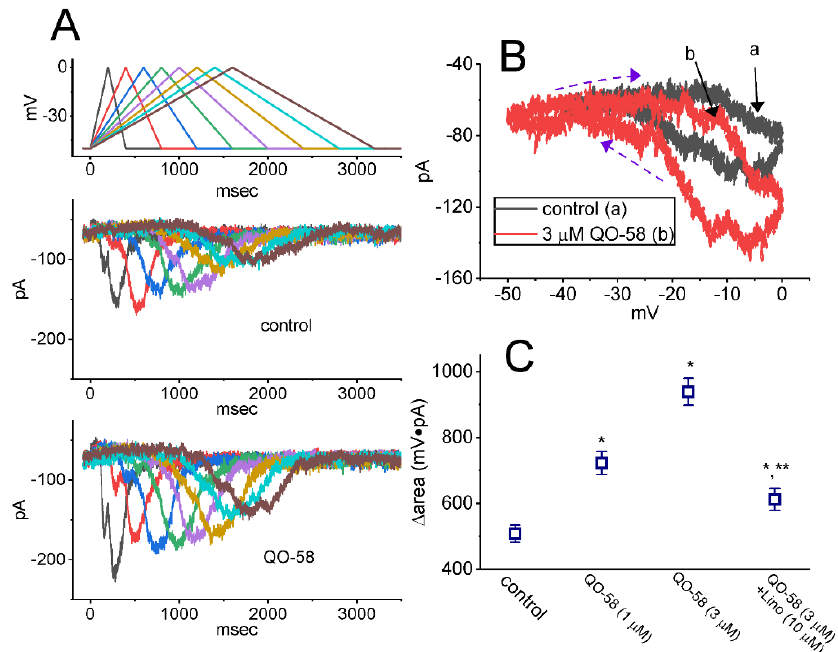
Figure 3. Effect of QO-58 on I K(M) in response to an upright isosceles-triangular ramp pulse (V ramp ) observed in GH 3 cells. The V ramp with different durations (0.4–3.2 s) (or with ramp speed between ±31.25 and ±250 mV/sec) was designed to mimic different depolarizing and repolarizing slopes in bursting patterns of neuronal firing. ( A ) Representative I K(M) traces in response to the double-pulse V ramp in the absence (upper) and presence (lower) of 3 µ M QO-58. The voltage protocol used is indicated in the uppermost part, and voltage waveforms appearing in different colors are indicated to correspond with current traces evoked by the waveforms. ( B ) Effect of QO-58 (3 µ M) on voltage-dependent hysteresis (V hys ) (i.e., the relationship of forward and backward current versus membrane voltage) of I K(M) evoked by triangular V ramp with a duration of 3.2 s. Black or red current trajectory indicates the absence or presence of 3 µ M QO-58, respectively. The direction of I K(M) in which time passes during the elicitation by 3.2 s triangular V ramp is indicated by dashed arrows. ( C ) Summary scatter graph showing the effect of QO-58 on the V hys ’s ∆ area (mean ± SEM; n = 8 for each point). ∆ area means the area encircling the forward (upsloping) and backward (downsloping) limbs of current trajectory evoked by V ramp . * Significantly different from control ( p < 0.05), and ** significantly different from 3 µ M QO-58 alone group ( p <